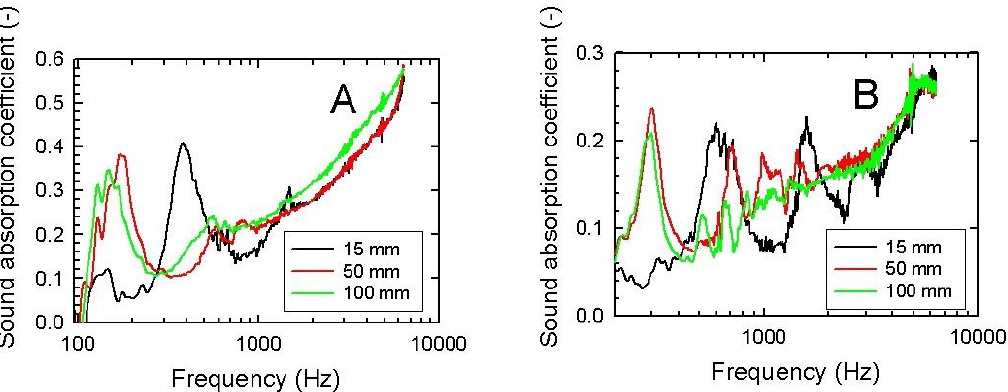
Figure 5: Frequency dependencies of the sound absorption coeflcient of studied particular fillers: A – wollastonite (sample 3), B – perlite (sample 4). Inset: Powder bed height in mm